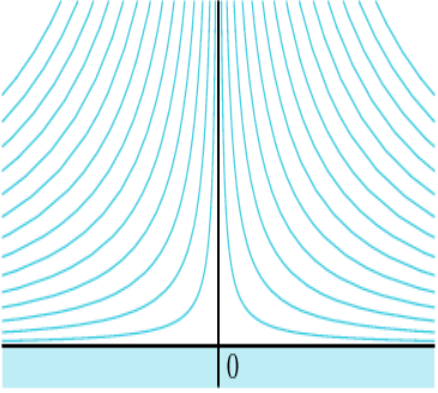
Figure 9. The fluid flow around an infinite wall.